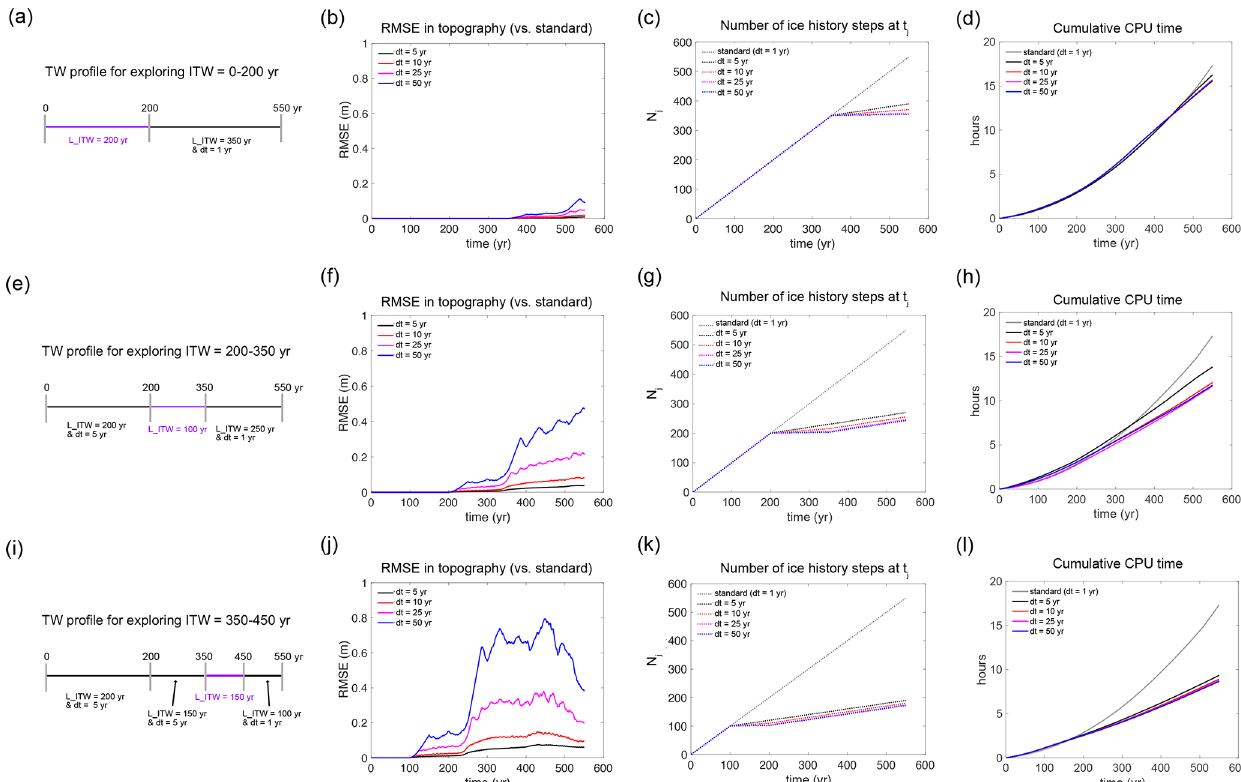
Figure 7. Time window profiles, RMSE in predicted topography, the number of loading events considered at t j ( N j ) and the total CPU times it has taken for the sea-level model to perform calculations at time step t j in the 550-year-long future AIS-scenario simulations. Results from the simulations in which we explore the internal time windows that cover the periods between (a–d) 0–200 years, (e–j) 200–350 years and (i–l) 350–450 years. Note that the standard simulation for the AIS scenario assigns a uniform time-step size of 1 year throughout the